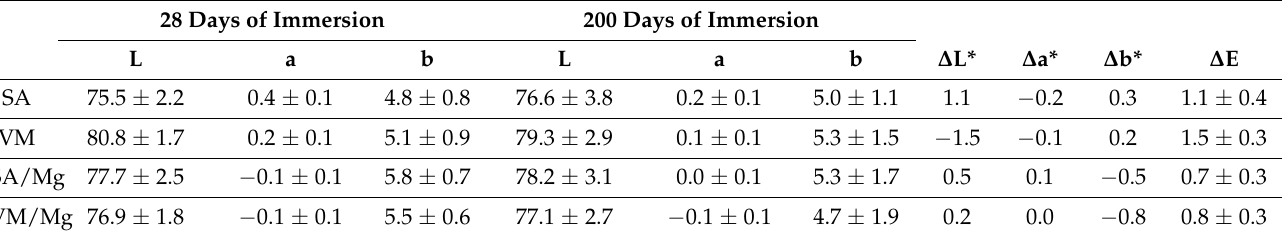
Table 4. Results of colorimetric